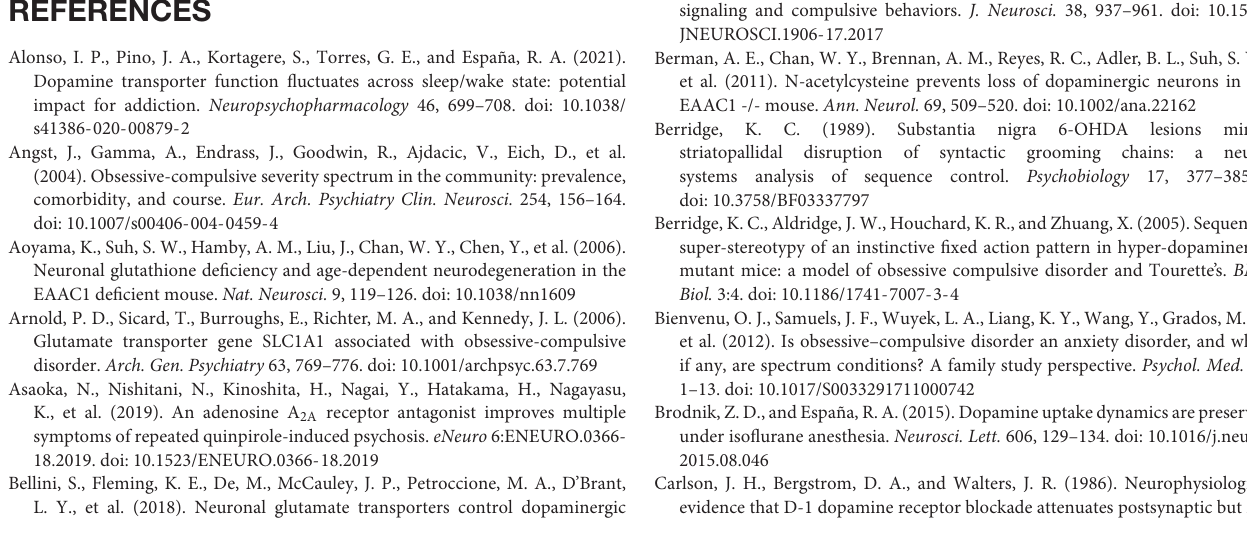
Supplementary Figure 1 | EAAT3 glo /CMKII mice show anxiety-like behavior. Mice were placed in an open-field arena (40 × 40 × 35 cm) and allowed to freely explore for 5 min. The time spend in center (20 × 20 cm) was analyzed. P = 0.03, according to unpaired T -test. EAAT3 glo n = 11 (6M, 5F); EAAT3 glo /CMKII n = 8 (5M,